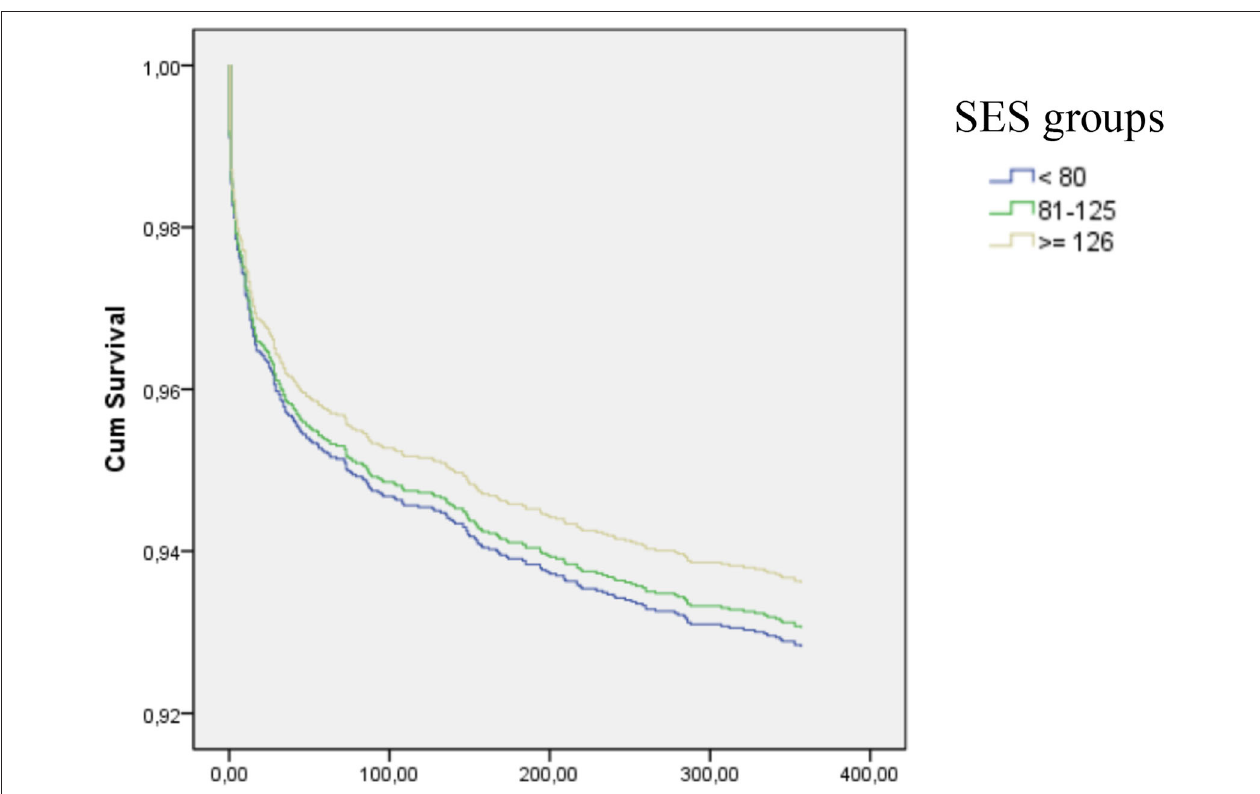
FIGURE 2 | Cumulative survival according to socioeconomic status (SES). Global log-ranked p -values = 0.79; mid SES vs. low SES = 0.78; high SES vs. low SES = 0.49.